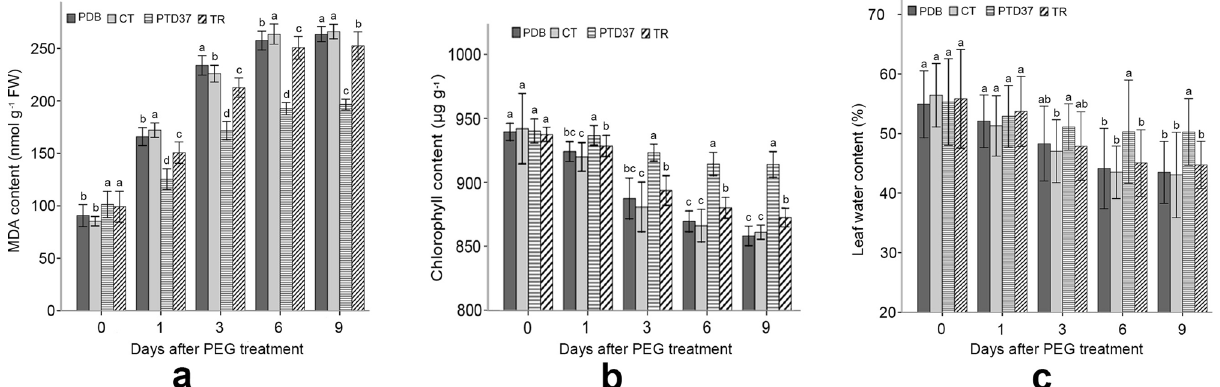
Figure 4. Effect of different treatments on the MDA, chlorophyll, and water contents of seedling leaves before and after PEG application. ( a ) Effect of PEG application on the leaf MDA content of seedlings under different treatments. ( b ) Effect of PEG application on the leaf chlorophyll content of seedlings under different treatments. ( c ) Effect of PEG application on the leaf water content of seedlings under different treatments. PDB potato dextrose broth, PTD37 fermentation broth supernatant of the PTD37 strain, TR fermentation broth supernatant of T. harzianum . Data are the means ± SD from five independent tests. Different letters on error bars indicate significant differences at P = 0.05 between the analyzed composition contents of seedlings from different treatments on the same day after PEG application. The values on day 0 after PEG treatment indicate that these values were measured before PEG application.